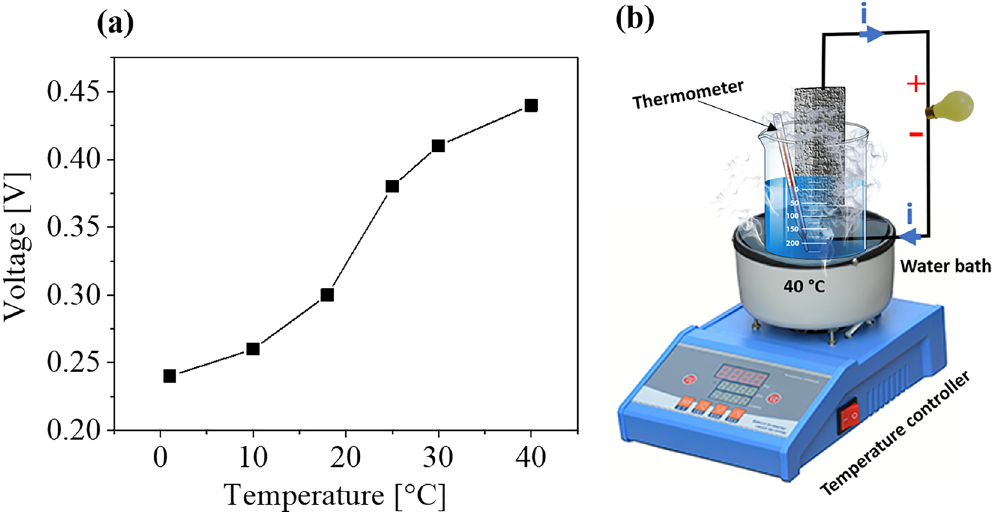
Figure 7. ( a ) Evaporation-induced voltage plotted as a function of temperature; ( b ) Schematic representation of water transpiration through